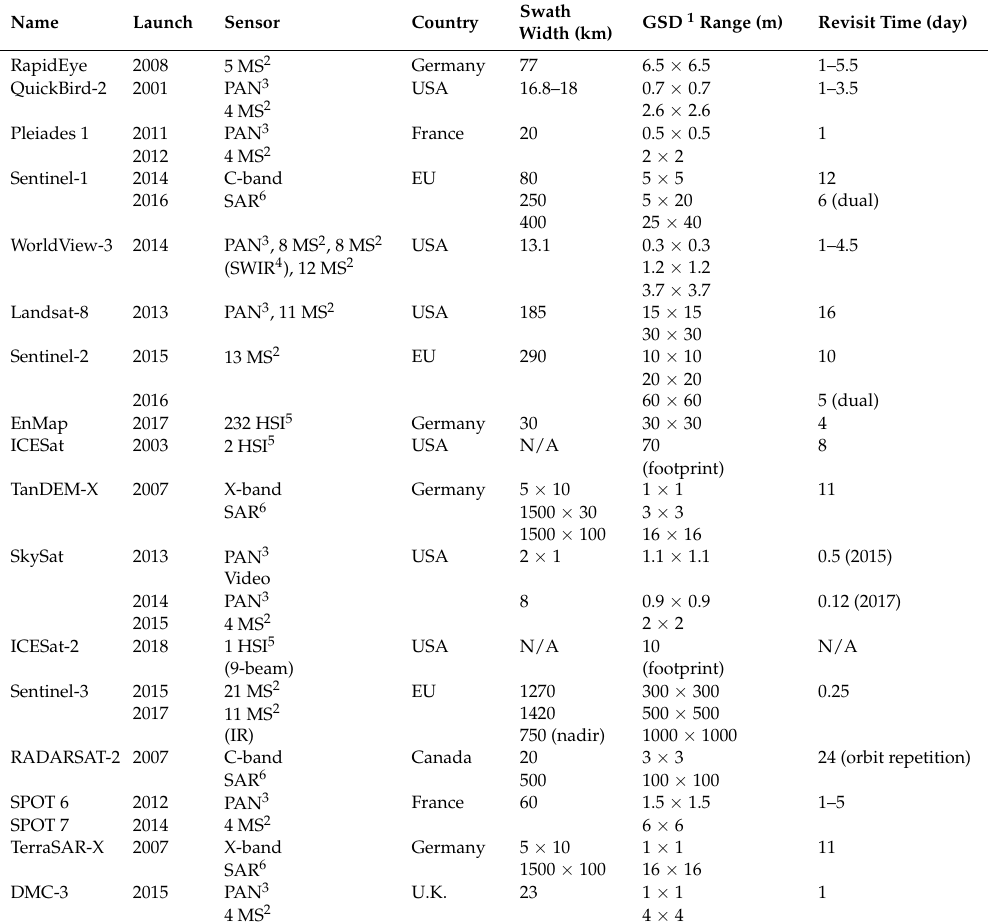
Table 5. Satellite platforms for